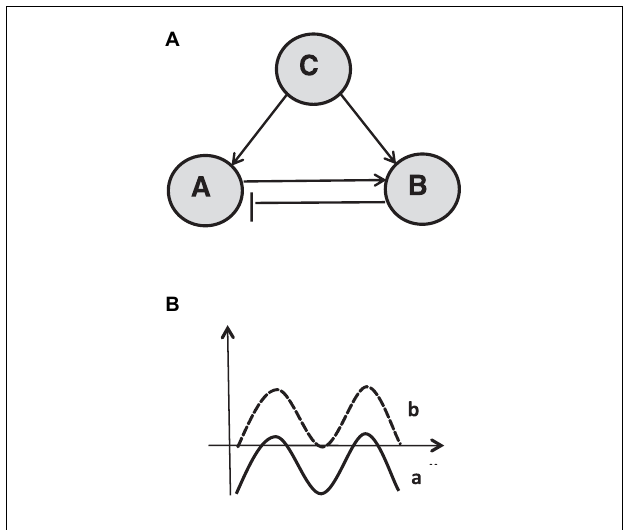
FIGURE 4 | Network of oscillatory behaving activator-inhibitor module. (A) Activator A and inhibitor B are driven by activator C. (B) Non-linear behavior pattern generated by this module (oscillation). Activity of unit A (B) can be changed (e.g., elevated) by increase of activity of